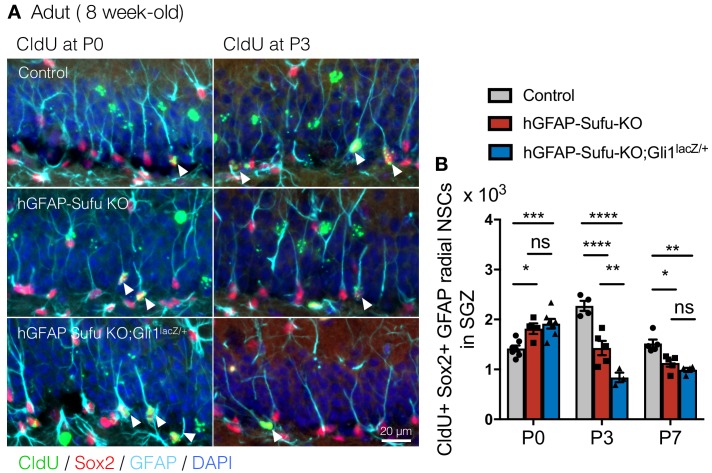
Deletion of Sufu prematurely induces the quiescent state transition.(A) Representative immunofluorescence images for CldU (green), Sox2 (red), GFAP (cyan) and DAPI (blue) in the SGZ of animals injected CldU at different stages. White arrowheads indicate the CldU+/Sox2+/GFAP +radial NSCs. (F) Quantification of CldU+/Sox2+/GFAP +radial NSCs in the SGZ [P0 CldU: Control, n = 7; hGFAP-Sufu-KO, n = 4; hGFAP-Sufu-KO;Gli1lacZ/+, n = 7; P3 CldU: Control, n = 4; hGFAP-Sufu-KO, n = 5; hGFAP-Sufu-KO;Gli1lacZ/+, n = 3; P7 CldU: Control, n = 5; hGFAP-Sufu-KO, n = 5; hGFAP-Sufu-KO;Gli1lacZ/+, n = 4]. Values represent mean ±SEM; ns: p>0.05, *p<0.05, **p<0.01, ****p<0.0001. ANOVA with Tukey post-hoc tests.10.7554/eLife.42918.026Figure 6—figure supplement 1—source data 1.Extended numerical data and statistical analysis for Figure 6—figure supplement 1.